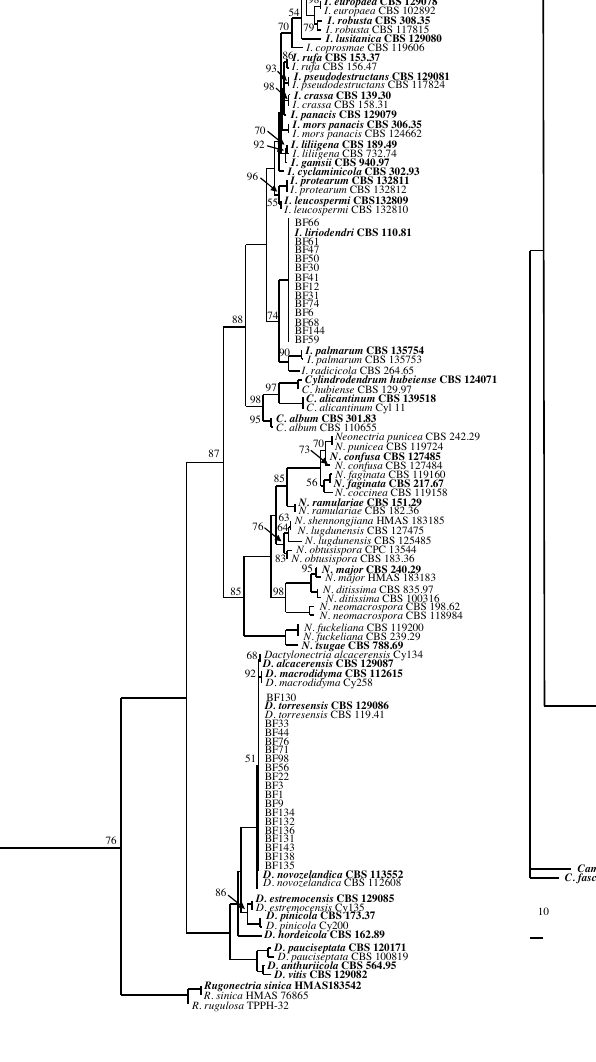
Figure 3. One of the 1,000 most parsimonious trees obtained from alignment of the ITS and β -tub sequence data, with bootstrap values from 100 replicates from maximum parsimony. Only bootstrap values <99 are shown at the internodes. Ex-type sequences are highlighted in bold. Campylocarpon fasciculare and C. pseudofasciculare were included as